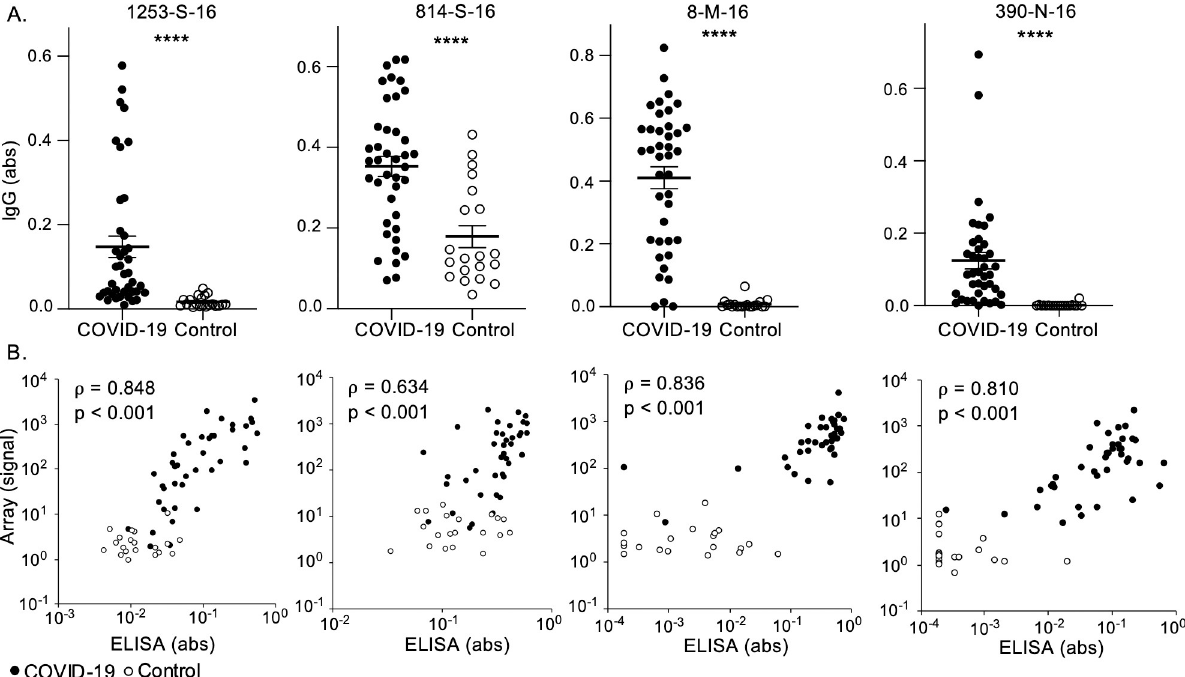
Fig 6. Higher IgG binding to SARS-CoV-2 peptides in COVID-19 convalescent patients compared to controls by ELISA. (A) IgG binding to SARS-CoV-2 peptides in COVID-19 convalescent ( n = 40) and na ï ve control ( n = 20) sera was measured by ELISA. Bars indicate mean abs +/ − SEM and ���� p < 0.0001 by t test. (B) Anti-SARS-CoV-2 peptide IgG detected by ELISA was compared to array findings by Spearman rank-order correlation (Spearman correlation coefficient, ρ ) for COVID-19 convalescent ( n = 40, closed circles) and control ( n = 20, open circles) sera. The data used in this analysis can be accessed online at: https://github.com/Ong-Research/UW_Adult_Covid-19. abs, absorbance; COVID-19, coronavirus disease 2019; ELISA, enzyme-linked immunosorbent assay; IgG, immunoglobulin G; SARS-CoV-2, severe acute respiratory syndrome coronavirus 2; SEM, standard error of the